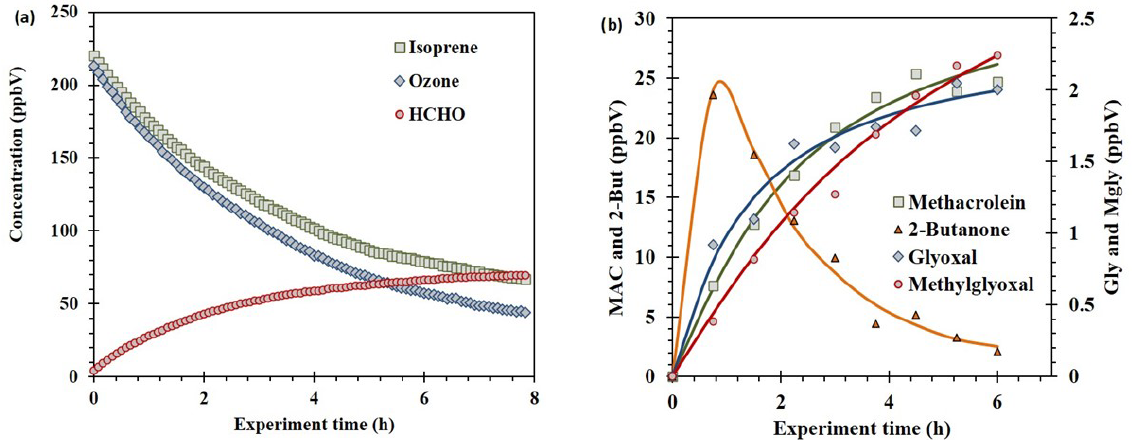
Figure 4. Concentration profiles obtained from ozonolysis of isoprene at the high-volume atmospheric simulation chamber. Reagents and the main product determined by FTIR (a) . Main multi-oxygenated organic compounds determined by on-line SPME–GC–MS (b) . [ Isoprene ] 0 = 220ppV; [ Ozone ] 0 = 215ppbV; [ CO scavenger ] = 230ppmV; reaction volume = 200m 3